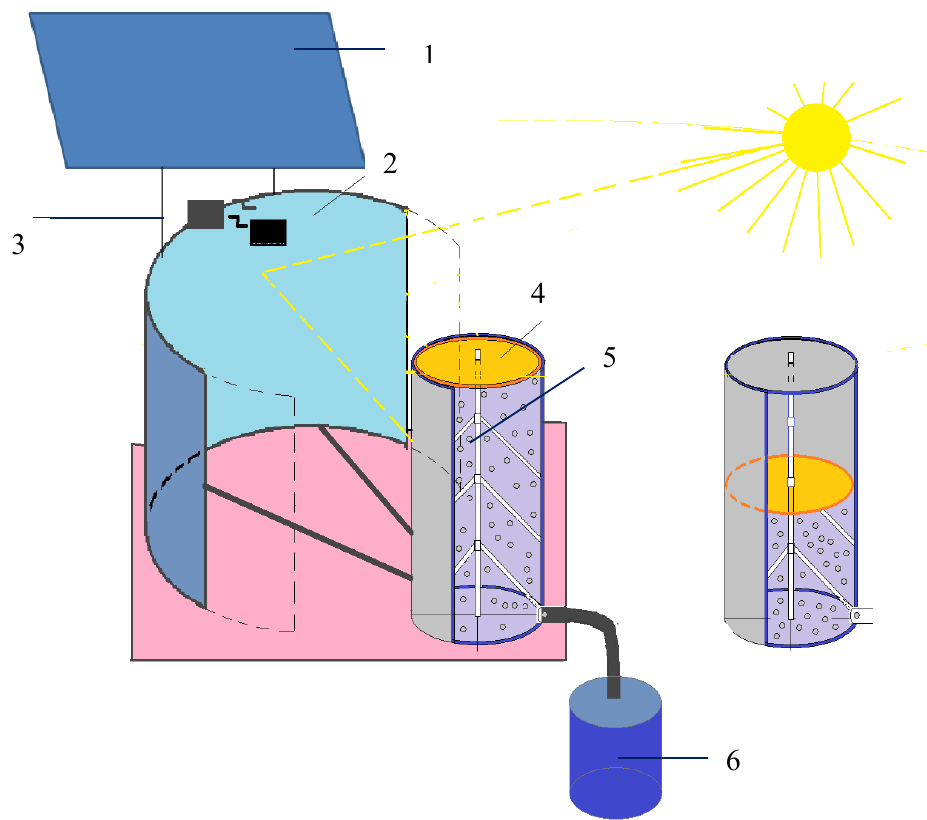
Fig. 4. Device for oil and oil products extraction during oil -containing wastes